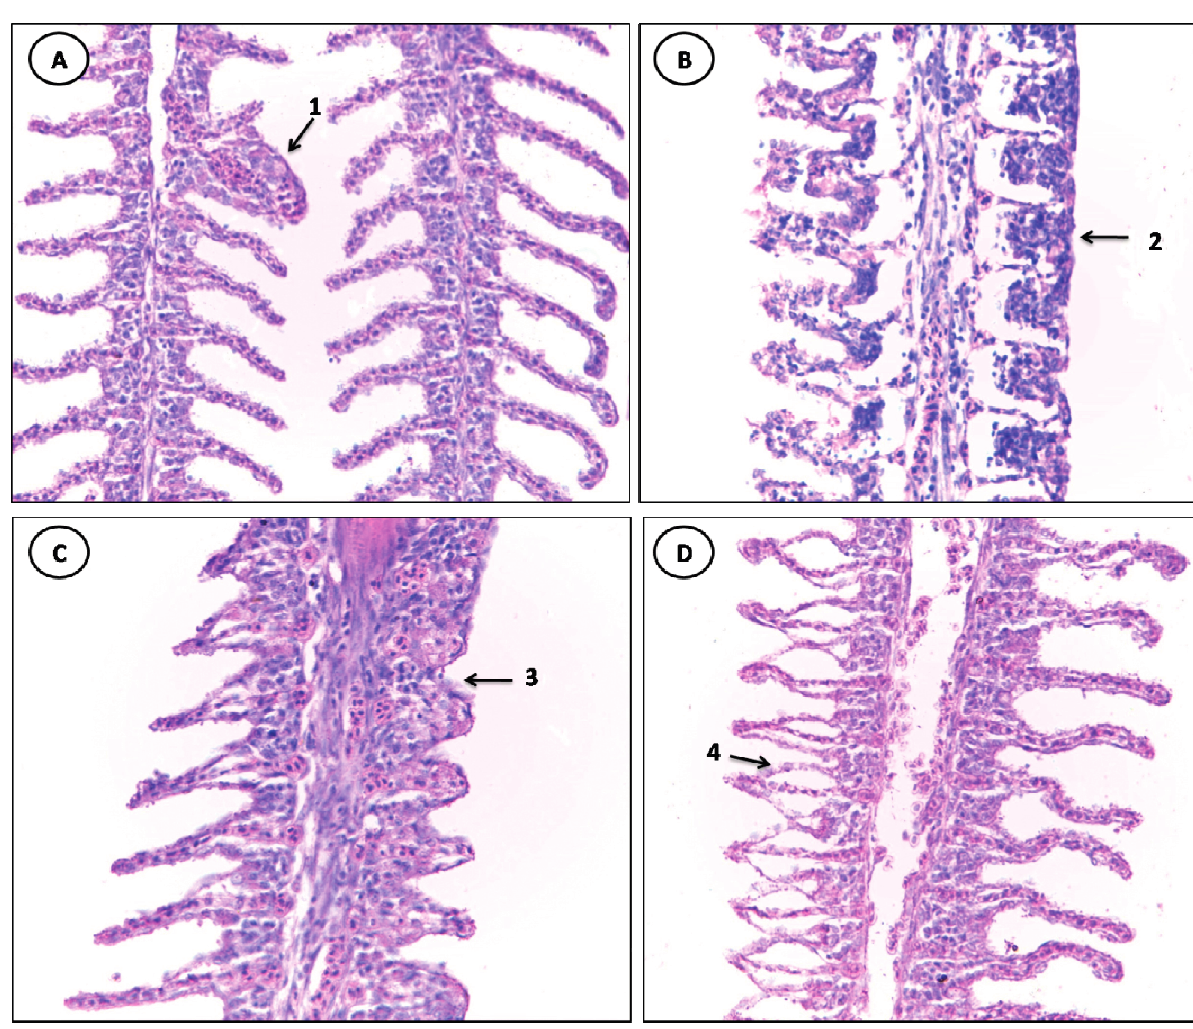
Figure 4. Histological alterations in the gills of C. undecimalis . ( A ) 1: aneurysm. ( B ) 2: complete fusion of several lamellae. ( C ) 3: incomplete fusion of several lamellae. ( D ) 4: lifting of the respiratory epithelium (HE staining, 400×